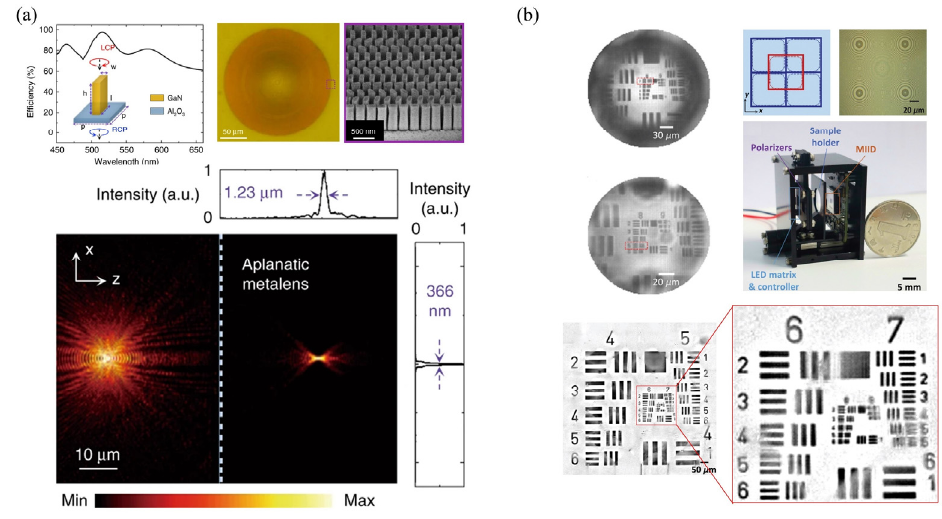
Figure 19. Portable singlet meta-lens microscopy setup: ( a ) macro-scale and nano-scale structure of a singlet meta-lens [110] and ( b ) a photograph of the singlet meta-lens microscopy setup with the resolution test result [111].